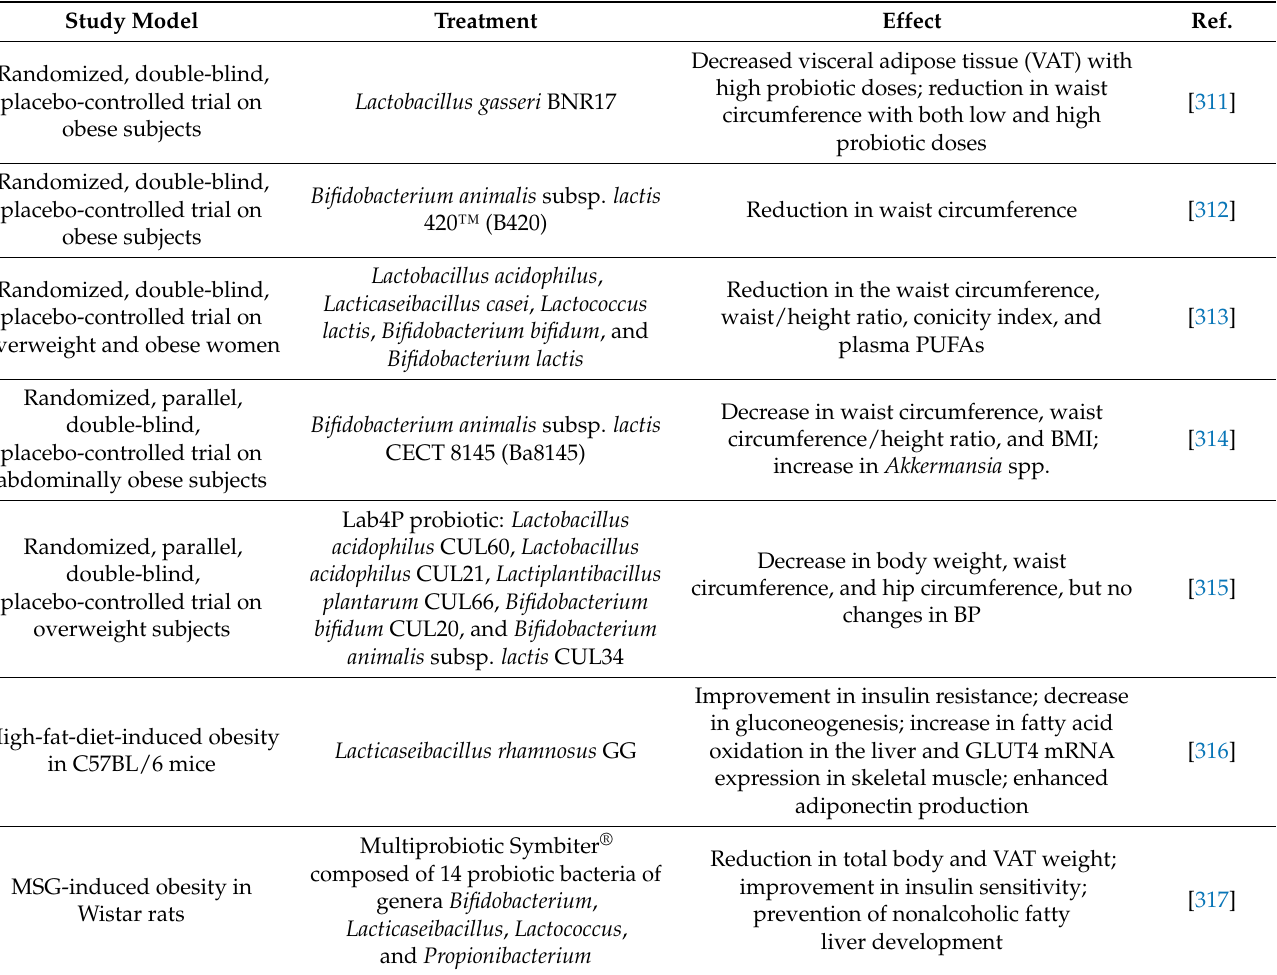
Table 5. Murine models and clinical trials on the use of probiotics in obesity and T2DM. Study Model Treatment Effect